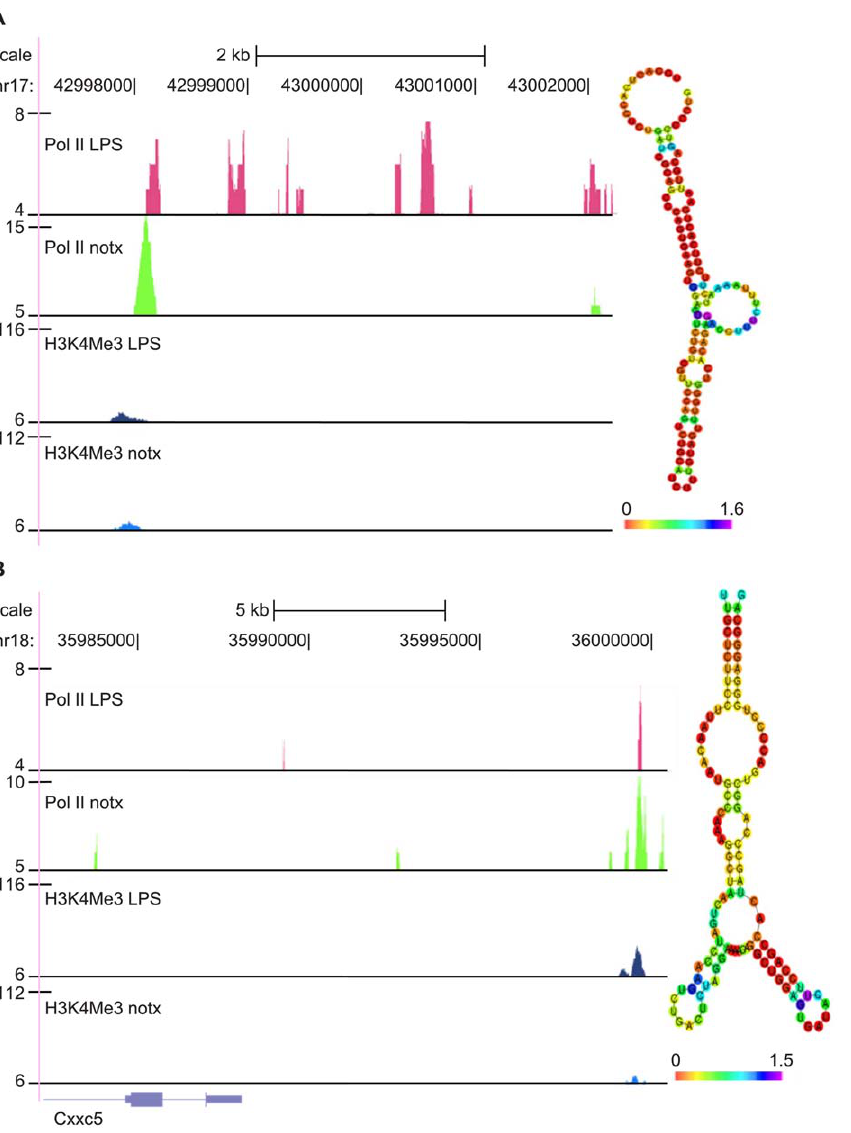
Figure 7. UCSC genome browser (mm8) snapshots of lincRNA examples (left), as well as their conserved, thermodynamically stable 2 nd structures predicted by RNAz (right). A: lincRNA located 5 9 distal side of Pla2g7 (phospholipase A2, group VII), whose Pol II tags are sensitively stimulated by LPS. B: lincRNA located 3 9 distal side of Cxxc5 (CXXC-type zinc finger protein 5), whose Pol II tags are sensitively repressed by LPS.